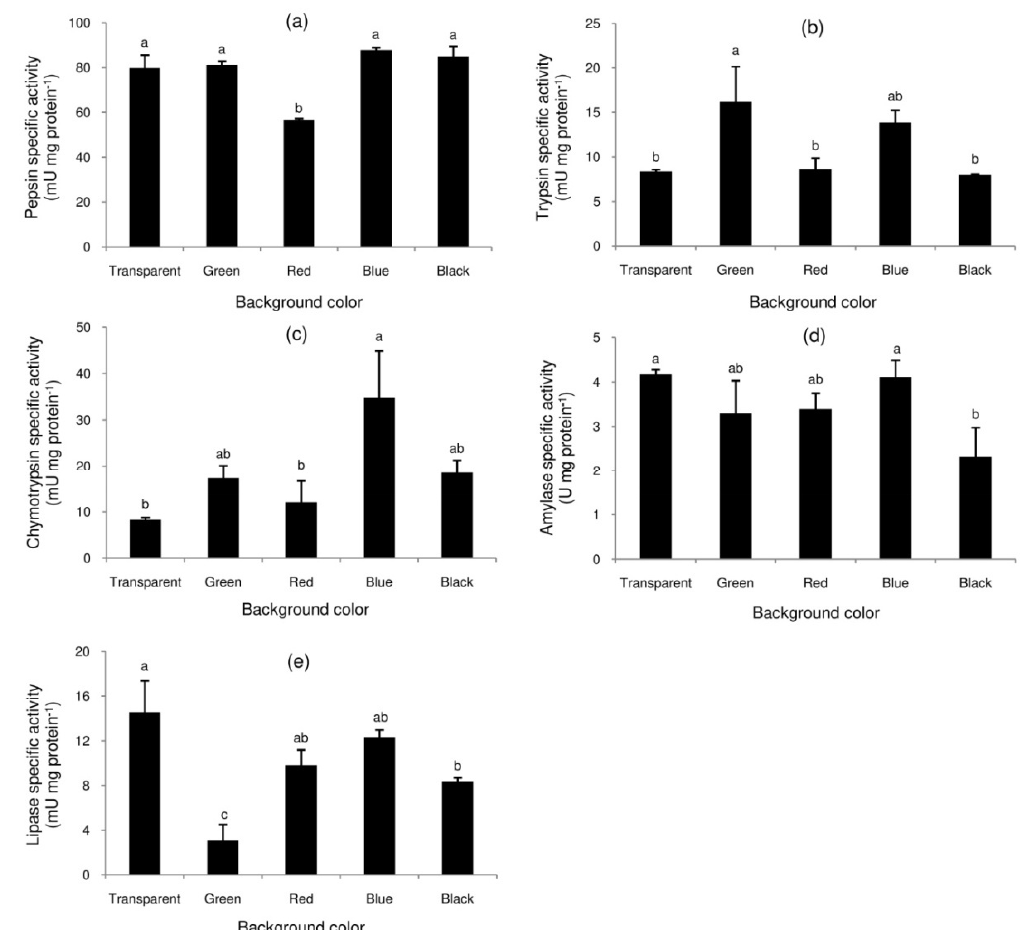
Figure 1. Specific activities of digestive enzymes in the feces of northern river terrapins reared with various background colors: pepsin (a), trypsin (b), chymotrypsin (c), amylase (d), and lipase (e). The feces were sampled at the end of the twelve-week experiment. Data are expressed as mean ± standard error of mean ( n = 3 per treatment). Different superscripts indicate a significant difference ( p < 0.05).